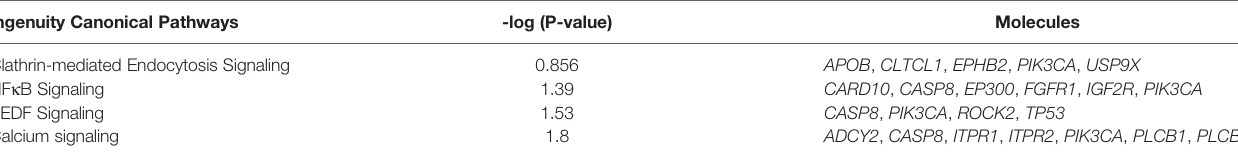
TABLE 3 | The canonical pathways of the top 200 frequently mutated genes in